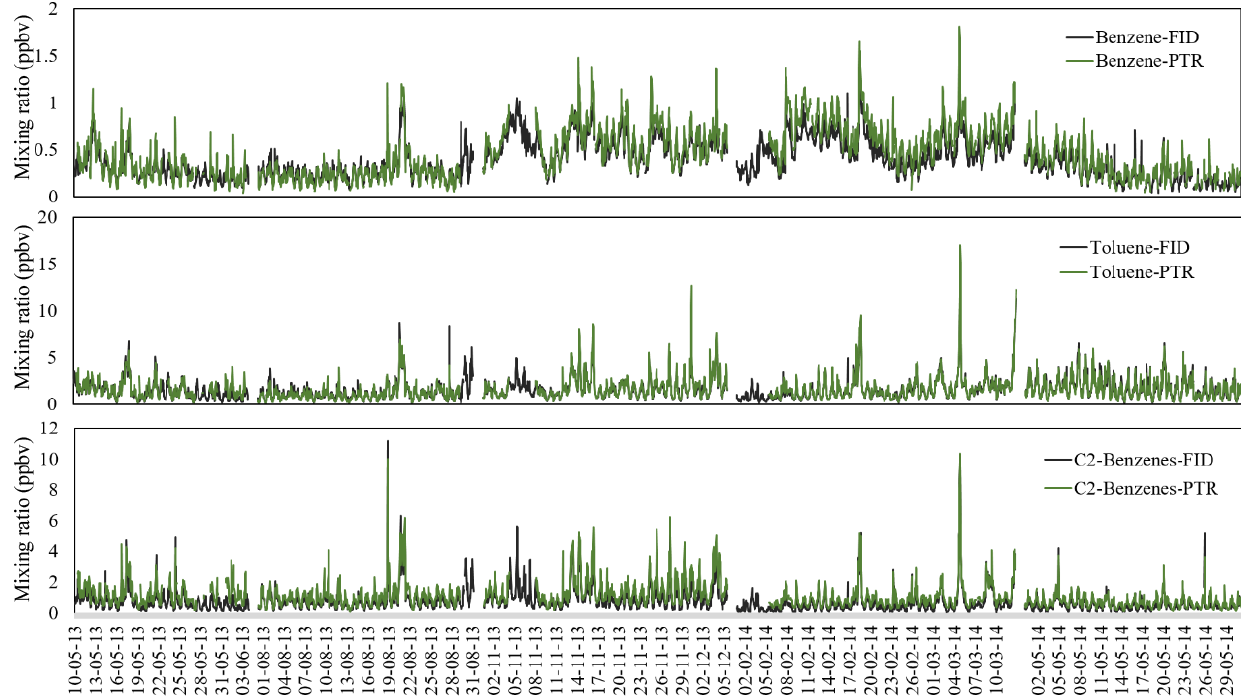
Figure 10. Measurement results for benzene, toluene, and C 2 -benzenes obtained during the field study at MK in Hong Kong. The black lines show the online GC-FID data, and the green lines show the PTR-MS